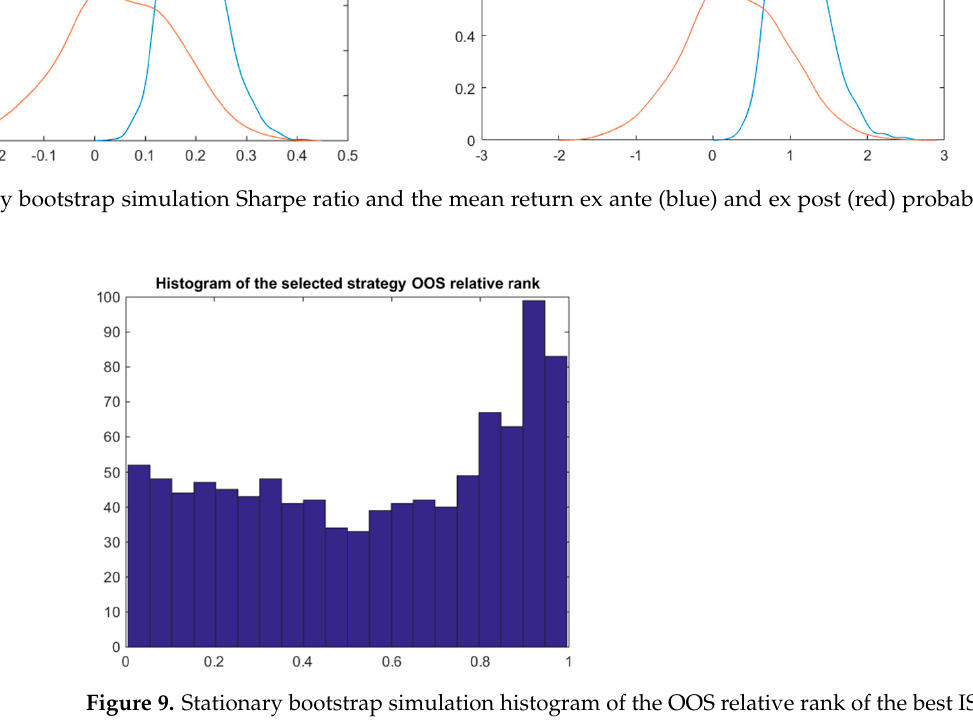
Figure 9. Stationary bootstrap simulation histogram of the OOS relative rank of the best IS strat- egy.